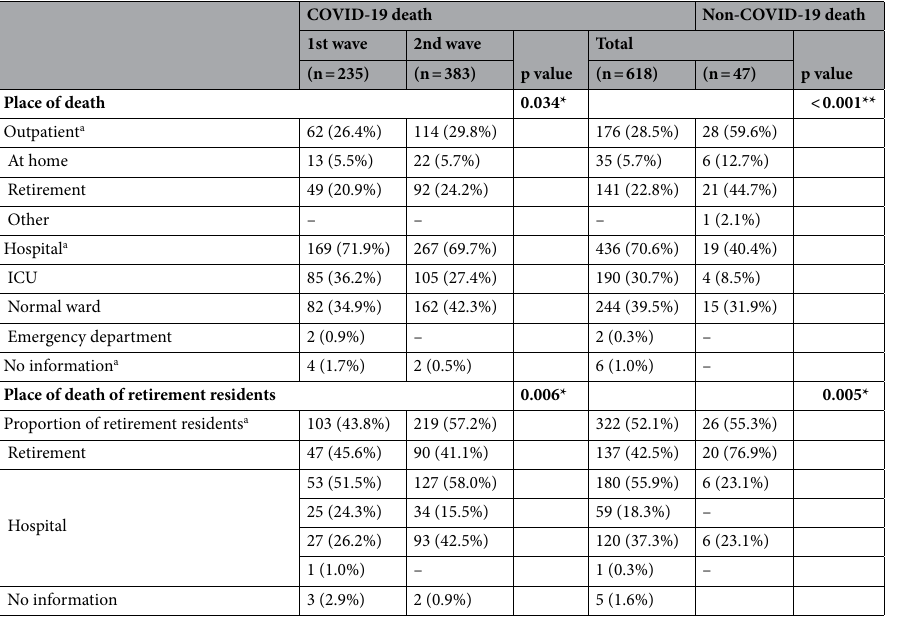
Table 2. Place of death of COVID-19 deaths and non-COVID-19 deaths (total N = 665; all unclear cases excluded). This table displays place of death of COVID-19 and non-COVID-19 deaths. In addition, the place of death of home residents is displayed. ICU intensive care unit. a Number (%). Statistically significant p values are highlighted in bold (*p < 0.05; **p < 0.001), the remaining values stayed